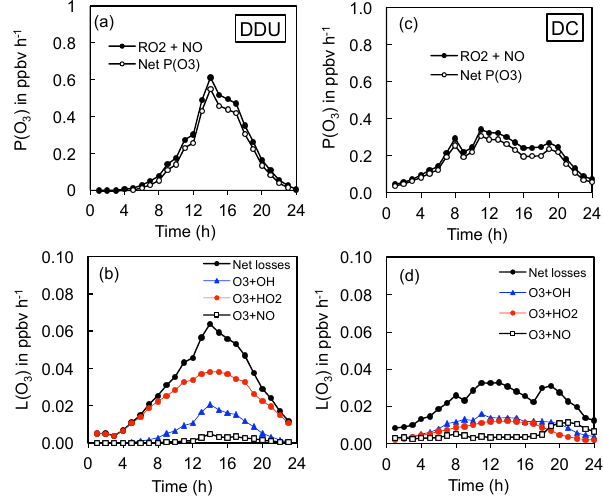
Figure 7. Ozone production (a, c) and loss (b, d) at DDU and Con- cordia calculated on the basis of observations summarized in Ta- ble 1. Time is local